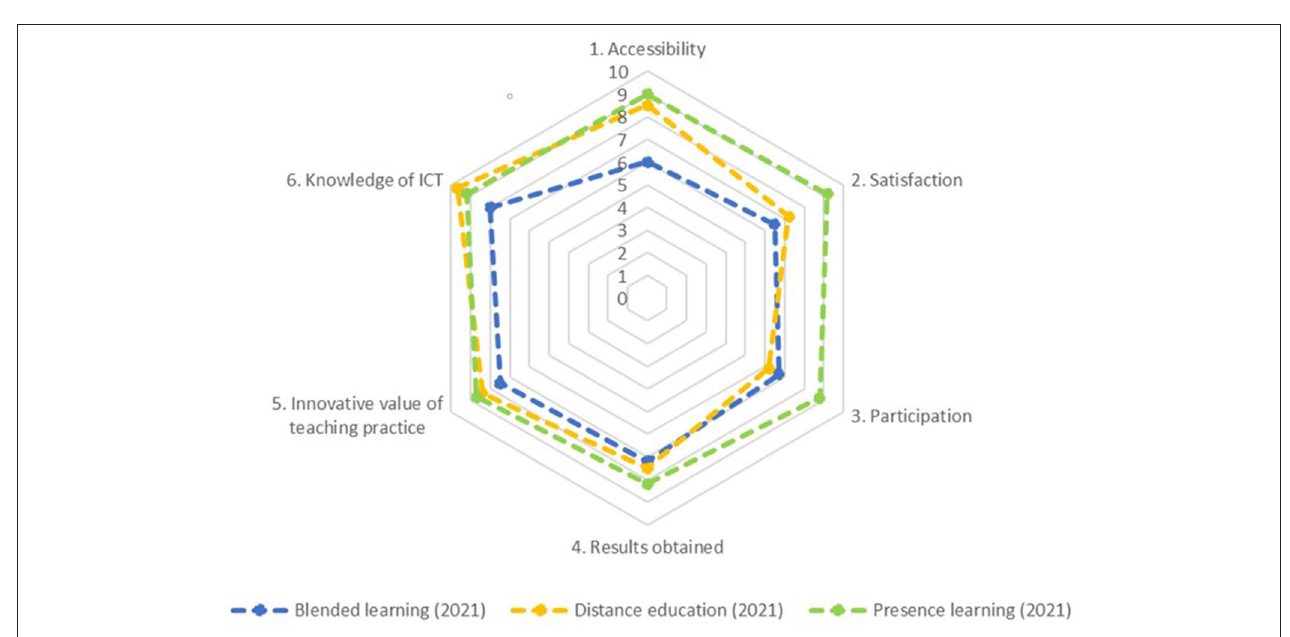
FIGURE 3 | Comparison of items in Study 2. Source: Own